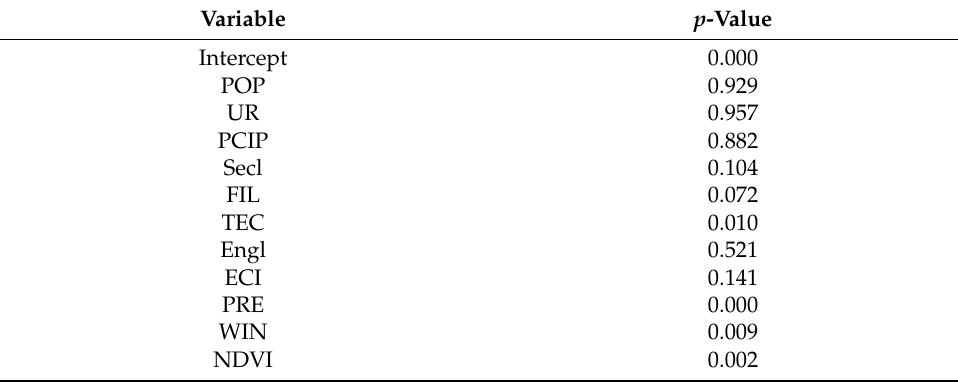
Table A3. Monte Carlo test for spatial variability.